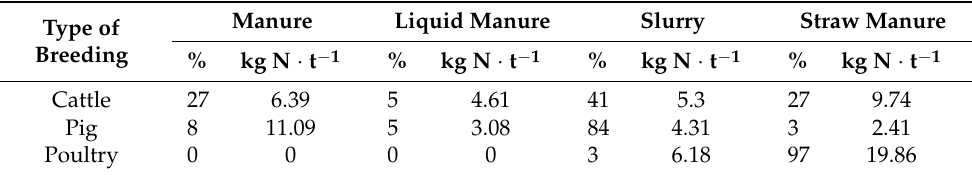
Table 1. Shares of manure, liquid manure, slurry and straw manure in animal excreta (in%) and its nitrogen content (kg